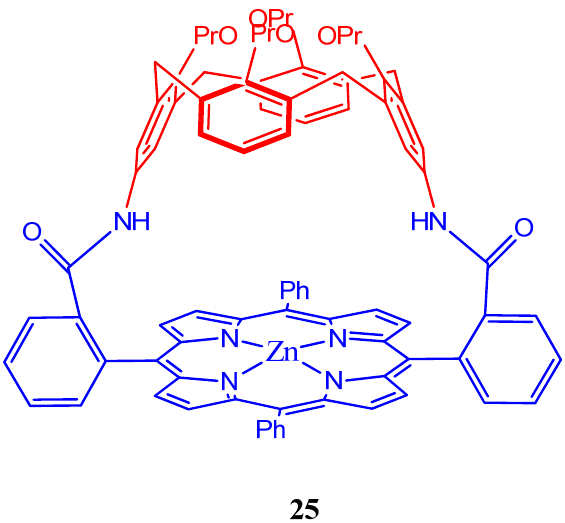
Figure 26. Calix[4]arene-capped Zn(II) porphyrin ( 25 ) capable of recognizing N -containing aromatic